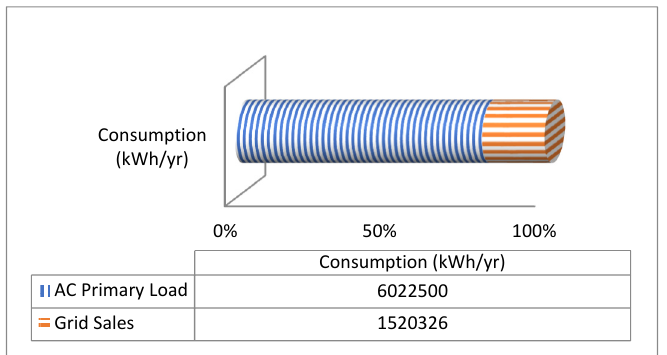
Figure 12. Electrical power consumption summary of the designed system.